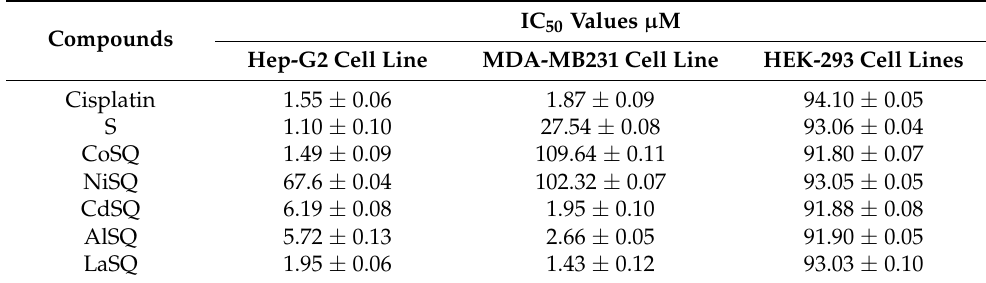
Table 8. IC 50 values in µ M for the salen ligand and its mixed 8-hydroxyquinoline metal complexes against Hep-G2 and MDA-MB231 cell lines compared to